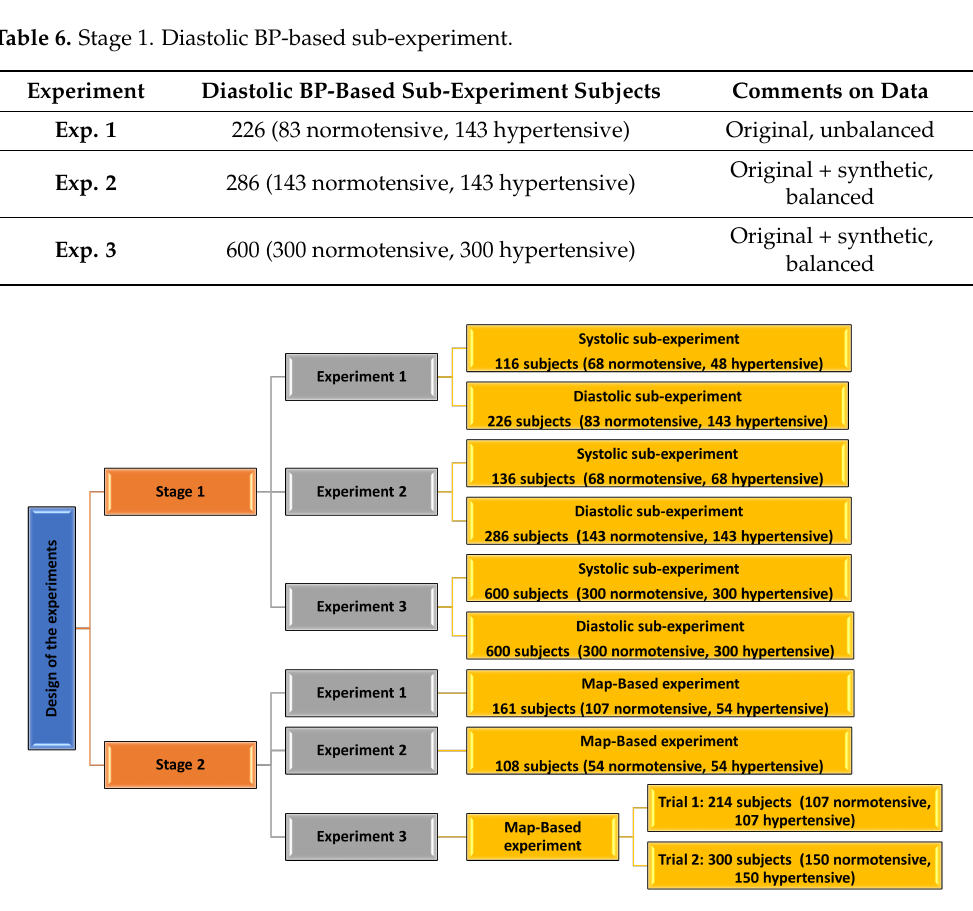
Figure 4. A block diagram showing details of the design of the conducted